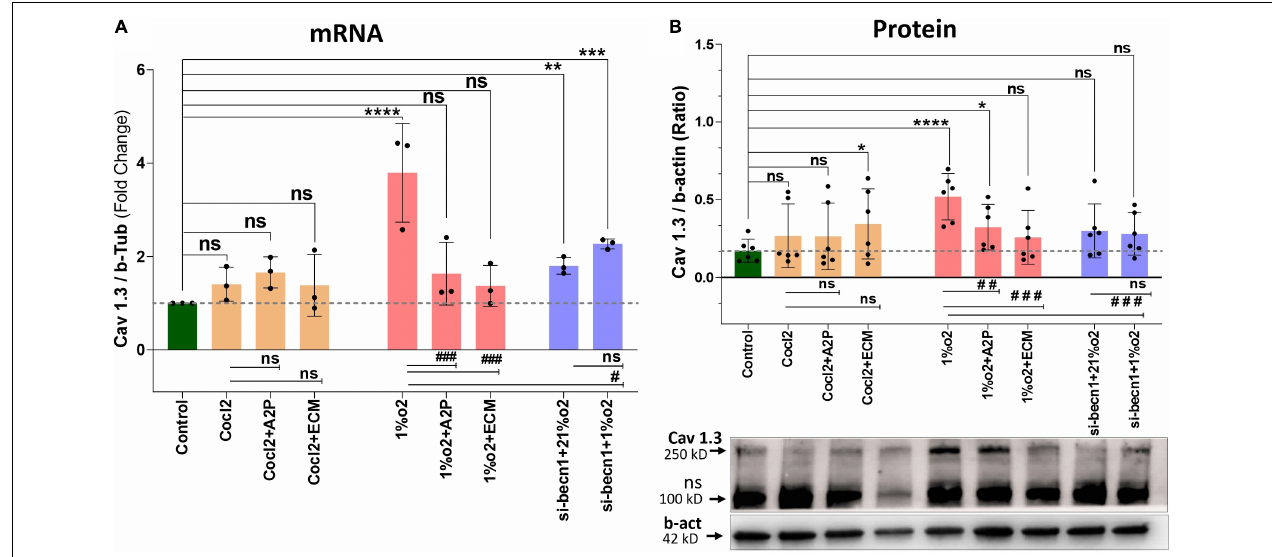
FIGURE 4 | Hypoxia and Cocl2 exposure modifies the H9c2 cells Cav1.3 (CACNA1D) expression at mRNA and protein level. (A) mRNA expression levels of Cav 1.3, (B) Cav1.3 Protein expression levels and representative western blots. Hypoxia increased the Cav1.3 expression both at mRNA (**** p < 0.0001) and Protein (**** p < 0.008) level. In addition, Beclin-1 inhibition significantly increased the Cav1.3 mRNA levels both in normoxia (21%o2) ** p < 0.001 and in hypoxia (1%O2) cells *** p < 0.0002, and protein expression levels was not changed significantly. Compared to Hypoxia cells Cav1.3 mRNA levels was decreased in 1%O2 + A2P ( ### p < 0.0005), 1%O2 + ECM ( ### p < 0.0001), and in Beclin-1 inhibition cells grown under Hypoxia ( # p < 0.013) and protein expression levels also decreased in 1%O2 + A2P ( ## p < 0.004), 1%O2 + ECM ( ### p < 0.001), and in Beclin-1 inhibition cells grown under Hypoxia ( ### p < 0.0003). Compared to control cells, Cocl2 exposure increased the Cav 1.3 protein expression levels in Cocl2 + ECM (* p < 0.022) group. No significant changes in Cav1.3 protein/mRNA expression level observed in all other groups compared to controls, Hypoxia and Cocl2. Data represents, n = 3 (mRNA) and n = 5 (Protein) independent samples/group. Bars are mean ± S.D. Symbols * , + , # and (cid:54)= denotes significant, “ns” represents not significant by two-way ANOVA- multiple comparisons test. P-values are ns p > 0.05, * p < 0.05, ** p < 0.01, *** p < 0.001 and **** p < 0.0001 compared to Control; + p < 0.05, ++ p < 0.01, +++ p < 0.001 and ++++ p < 0.0001 compared to Cocl2; # p < 0.05, ## p < 0.01, ### p < 0.001 and #### p < 0.0001 compared to Hypoxia; (cid:54)= p < 0.05, (cid:54)= (cid:54)= p < 0.01, (cid:54)= (cid:54)= (cid:54)= p < 0.001 and (cid:54)= (cid:54)= (cid:54)= (cid:54)= p < 0.0001 compared to si-becn1 (21%O2) Vs, si-becn1 (1%O2). In western blots “ → ” represents a specific signal, “ → ns” represents a non-specific